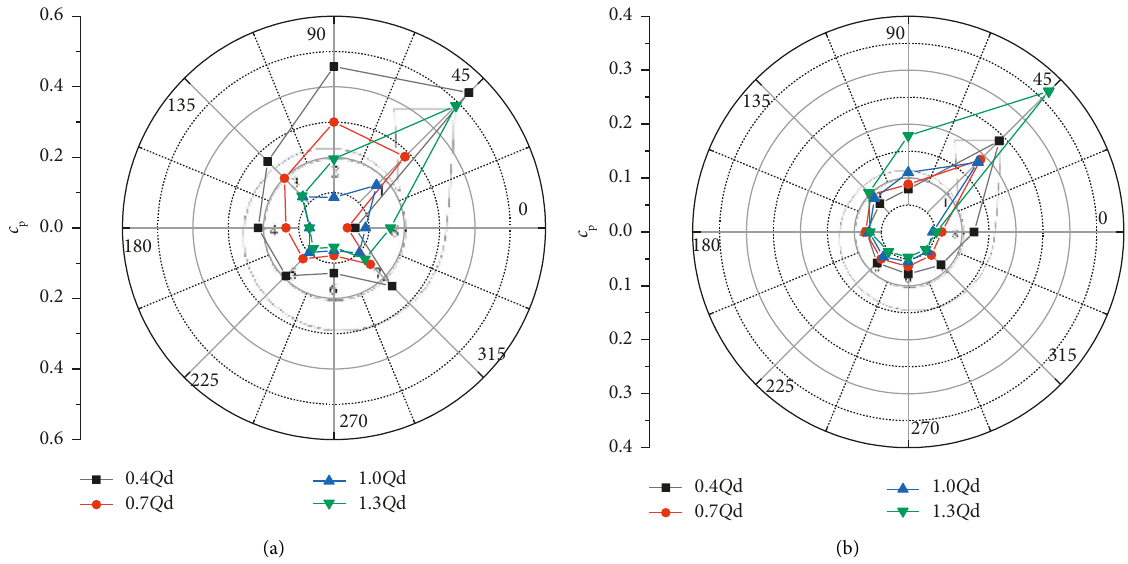
Figure 13: Pressure amplitude distribution under f BPF and 2 f BPF . (a) Pressure amplitude under f BPF and (b) pressure amplitude under 2 f BPF